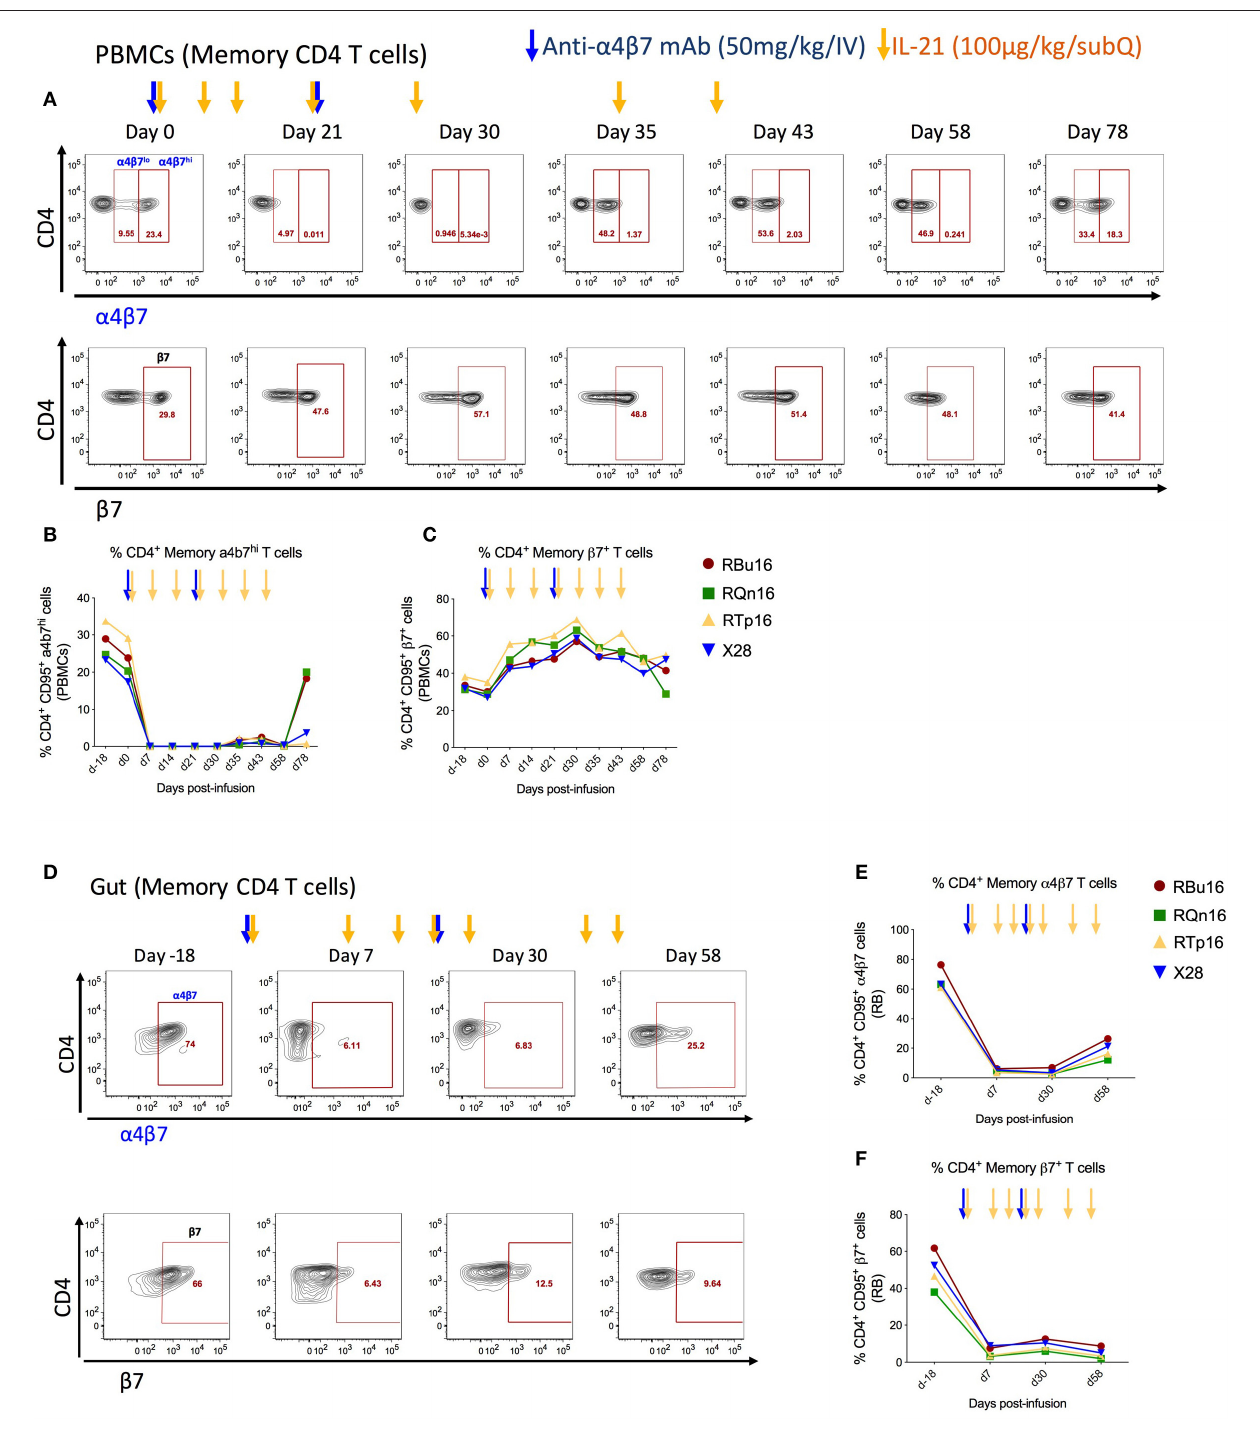
FIGURE 3 | Co-administration of anti- α 4 β 7 mAb and IL-21 decreases gut homing of CD4 α 4 β 7 hi to gut. (A) Representative flow cytometry staining of memory CD4T cells expressing α 4 β 7 hi (top panel) and β 7 + (bottom panels) in PBMCs. (B) Frequency of α 4 β 7 hi and (C) β 7 + memory CD4T cells in PBMCs. (D) Representative flow cytometry staining of memory CD4T cells expressing α 4 β 7 + (top panel) and β 7 + (bottom panels) in gut. (E) Frequency of α 4 β 7 + and (F) β 7 + memory CD4T cells in gut. Individual animals are represented with different colors and symbols. Baseline days are indicated as d-18 and d0. Blue arrows indicate the anti- α 4 β 7 mAb intravenous infusions, and yellow arrows indicate IL-21 subcutaneous infusions.